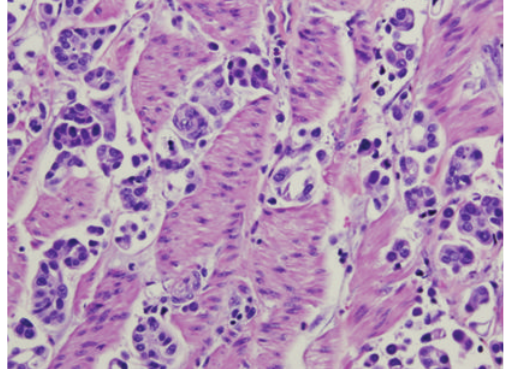
Figure 5: The tumor infiltrates between thick bundles of proper muscle